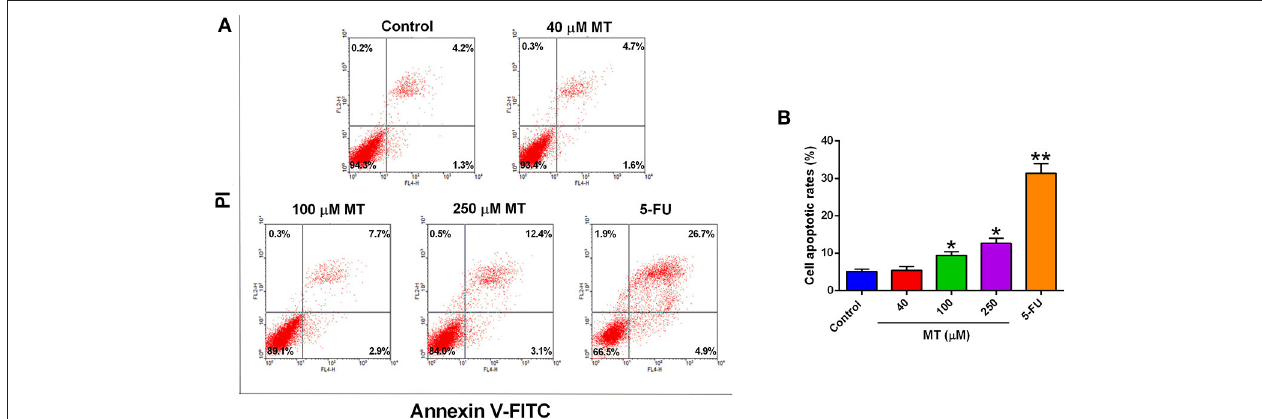
FIGURE 2 | Effects of MT treatment on the cell apoptosis of HepG2 cells. (A) HepG2 cells were incubated with different concentrations of MT for 48h and analyzed by flow cytometry. Histograms showed that distribution of apoptotic cells after different treatment. (B) Quantification of cell apoptosis from the histograms. Data from at least three independent experiments performed in triplicates are presented; * P < 0.05 and ** P < 0.01 compared to the corresponding control groups.